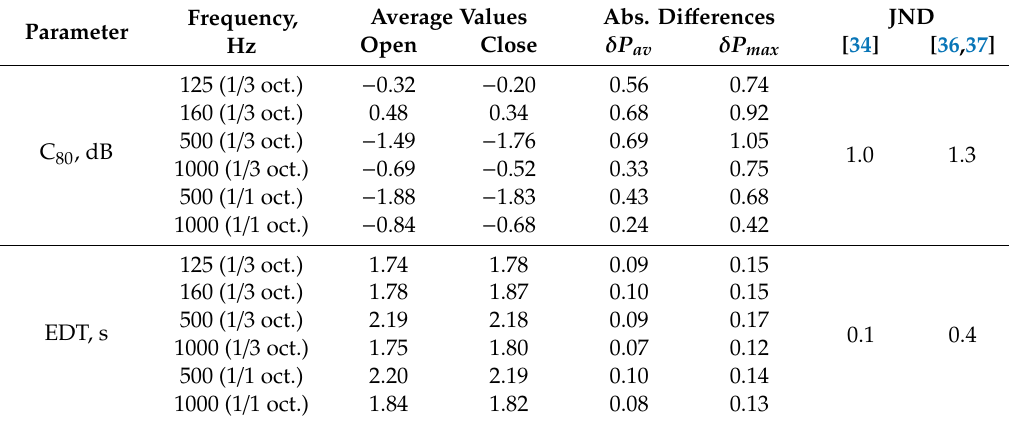
Table 2. Measured values of C 80 and EDT and their